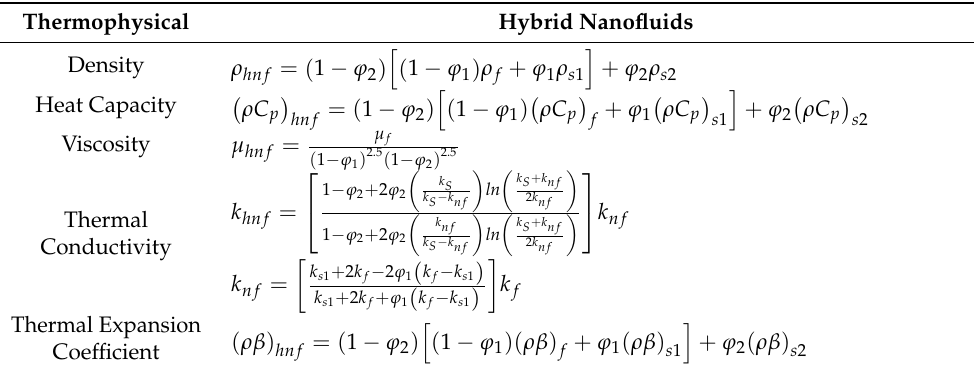
Table 2. Hybrid nanofluid’s thermophysical properties